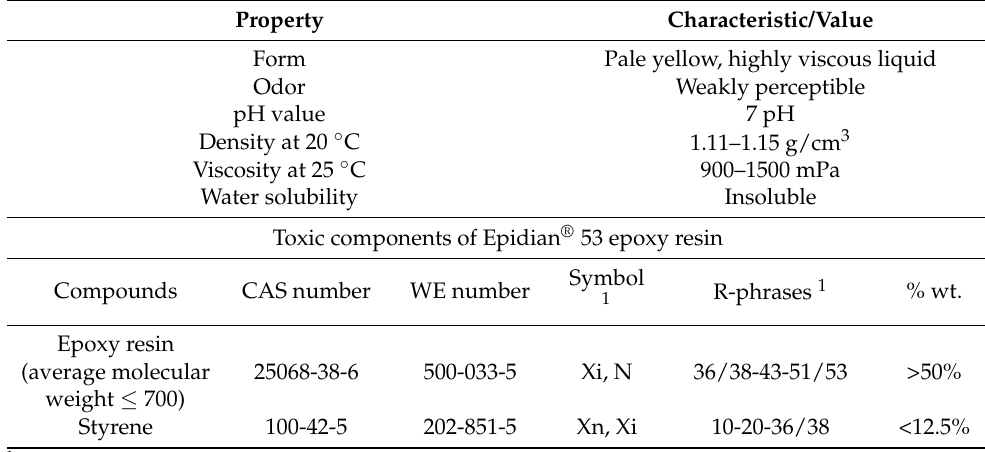
Table 2. Physical and chemical properties and toxic components of Epidian 53